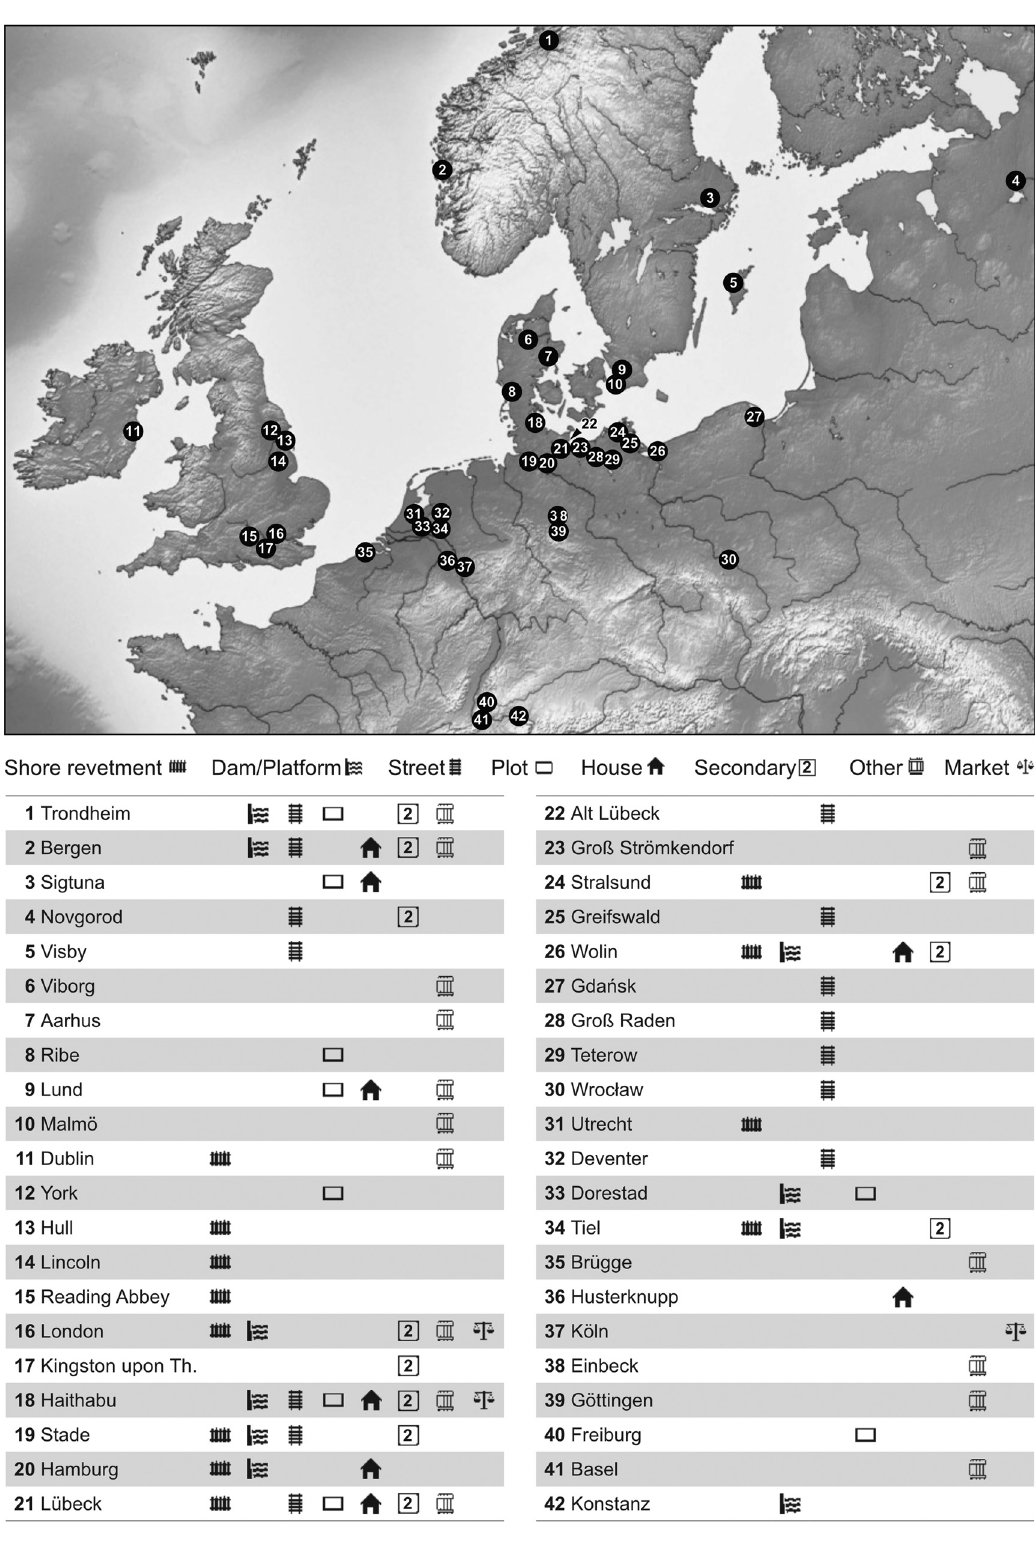
Figure 11: Parallels used for the interpretation of the Plessenstraße 83/3 features in step 15. It enables the critical reader to understand absences and tendencies ( Graphics: F. Rösch/A. Heitmann, symbols by Freepik, www. fl aticon.com )